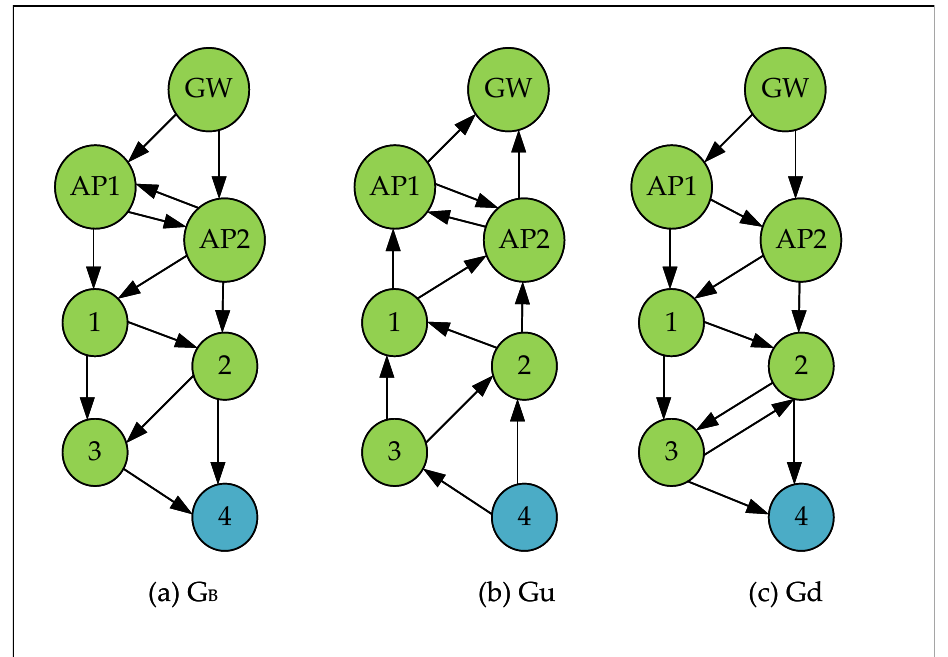
Figure 2. An example of the broadcast graph ( G B ) ( a ), uplink graph ( G U ) ( b ), and downlink graph ( G d ) ( c